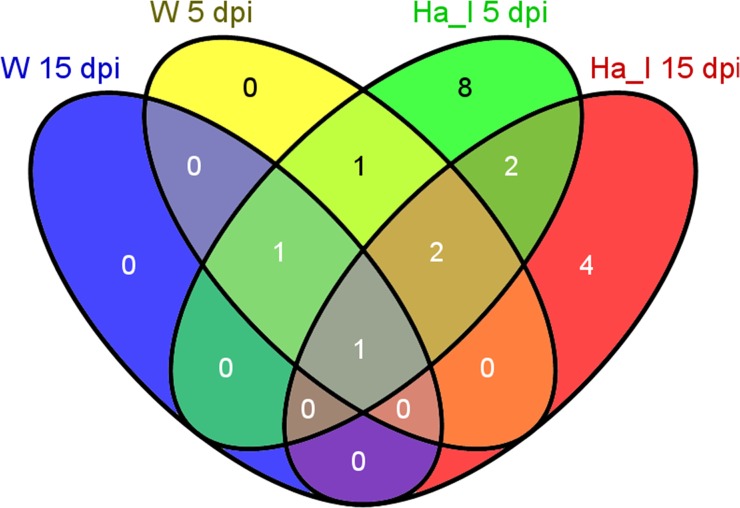
Differentially expressed transcripts in inoculation and wounding treatment relative to the control at different time points.A Venn diagram showing the differentially expressed genes (P-value <0.05 after FDR [Benjamini-Hochberg procedure]) at 5 dpi inoculation with H. annosum (green) or wounding (yellow) and 15 dpi inoculation with H. annosum (red) or wounding (blue).